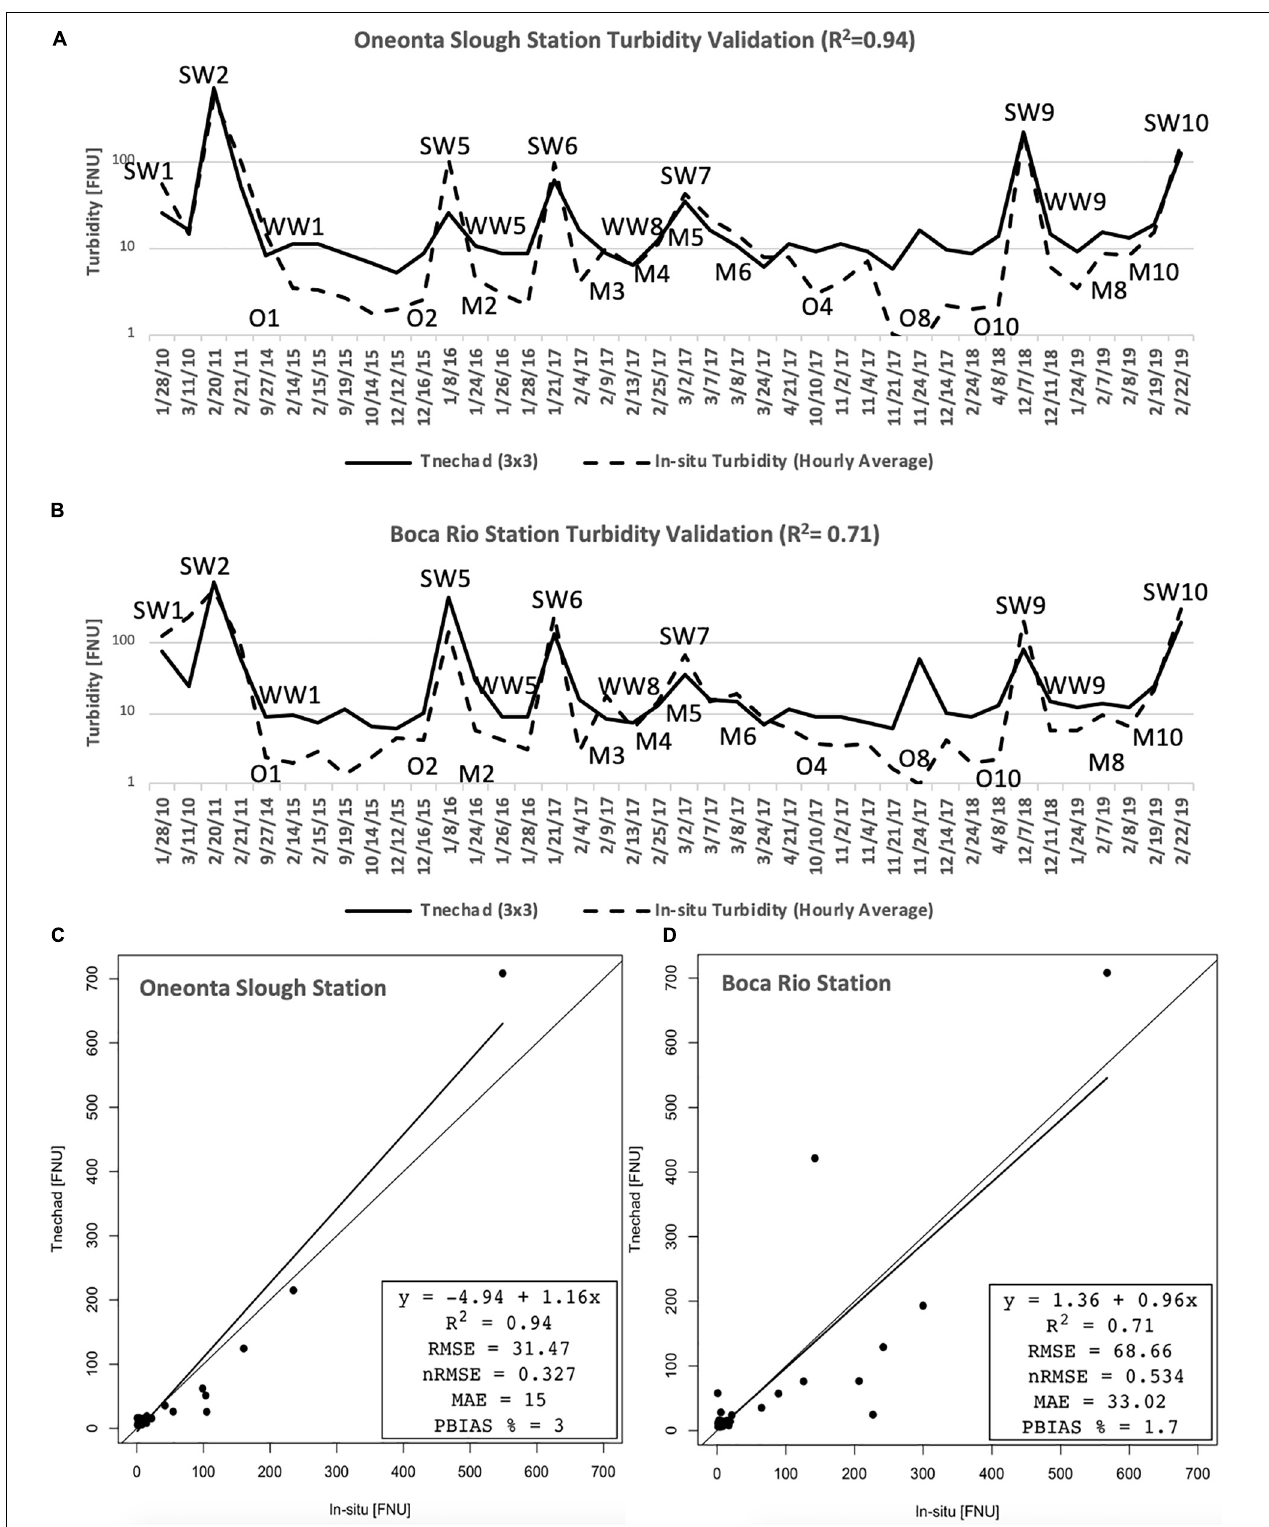
FIGURE 6 | Turbidity validation at the (A) Oneonta Slough Station and (B) Boca Rio Station. (C,D) The regression plots for both stations. Both stations have 40 points each: 10 stormwater, 10 wastewater, 10 mixed, and 10 no plume events.